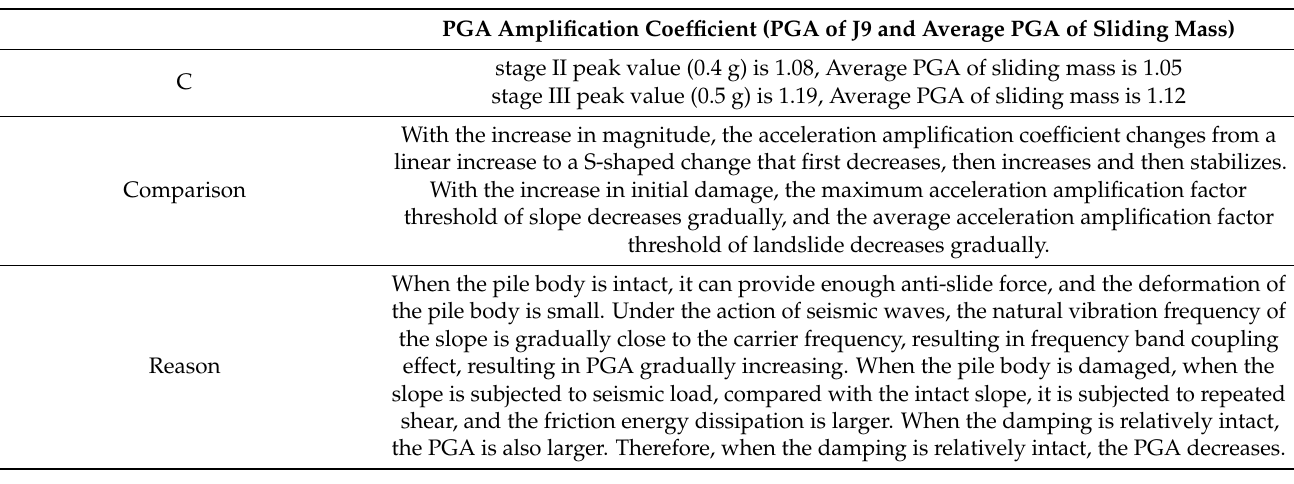
Table 8. Shear strain.